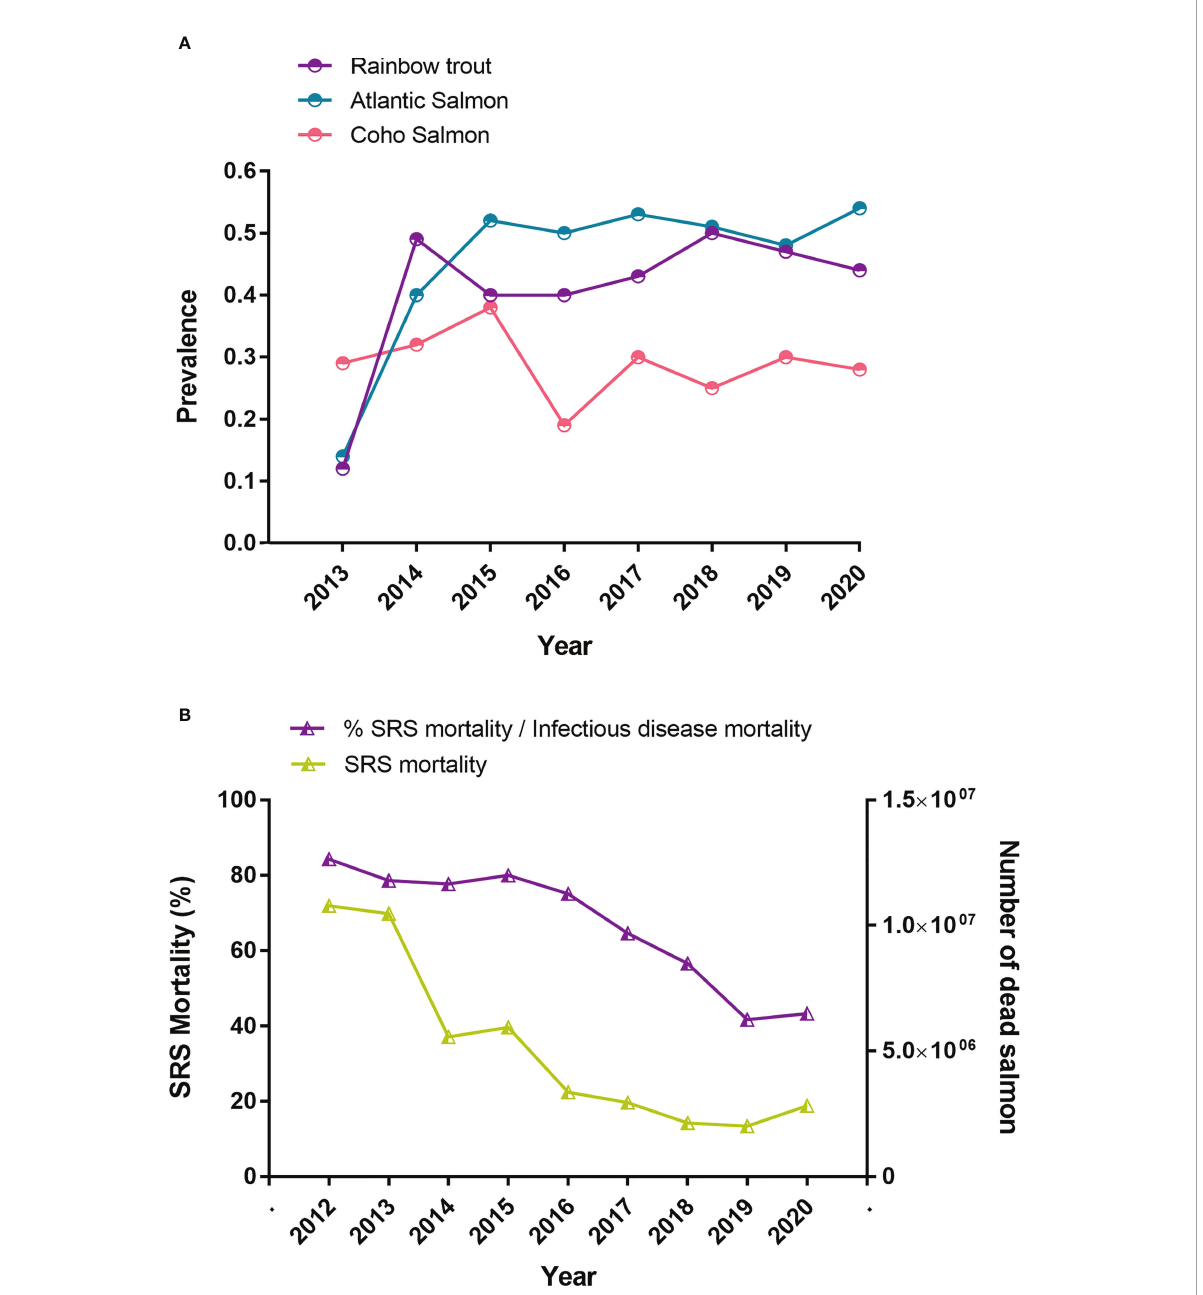
FIGURE 2 Impact of Piscirickettsiosis in farmed salmoninds in Chile. (A) Prevalence of Piscirickettsia salmonis in marine centers from 2013 until 2020. (B) Mortality due to P. salmonis in relation to the total mortality due to infectious causes from 2012 until 2020 (source: National Fisheries Services of Chile, 2022). Note that prevalence monitoring became more robust in 2014 after a year of its implementation in Atlantic salmon and rainbow